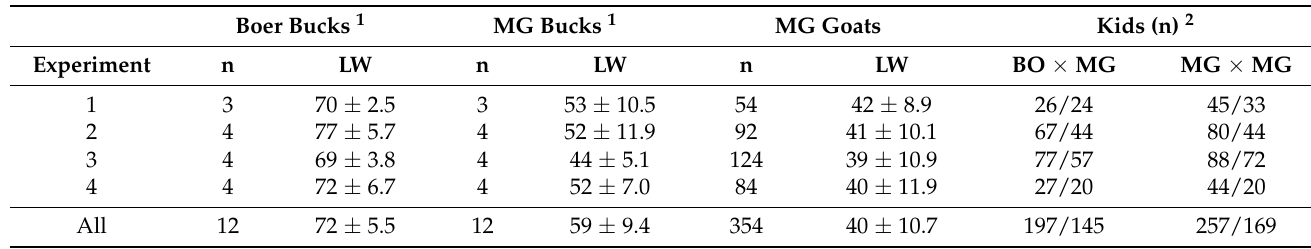
Table 1. Number (n) and live weight (LW, kg; mean ± SD) of bucks and goats, and number of kids used in each of four experiments performed to study the terminal crossbreeding of Boer (BO) bucks with Murciano-Granadina (MG) goats. Boer Bucks 1 MG Bucks 1 MG Goats Kids (n) 2 Experiment